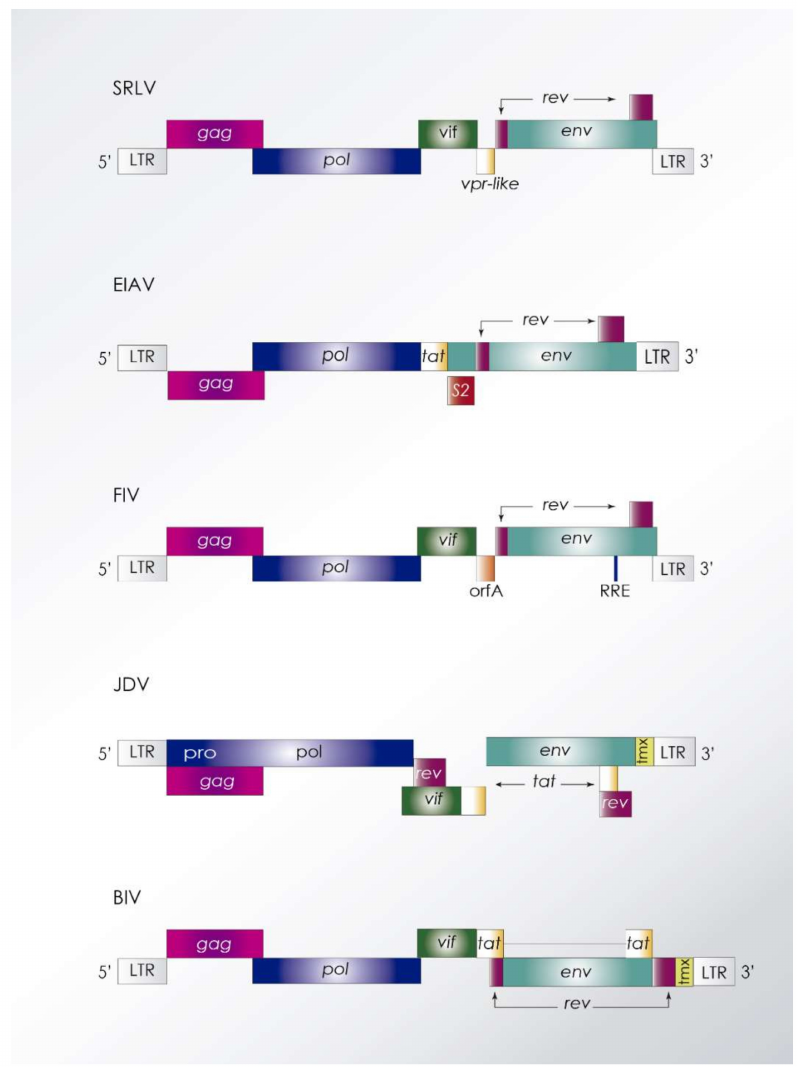
Figure 2. Proviral genomic structure of most common animal lentiviruses. Genes gag , pol , and env , as well as flanking long terminal repeats (LTRs), are common features among animal lentiviruses. Small ruminant lentiviruses (SRLV) encode three accessory genes vif , vpr -like, and rev without evidence of a transactivation activity [8]. Equine infectious anemia virus (EIAV) encodes an S2 gene whose protein may accomplish a function similar to that exerted by HIV Nef [9]. Feline immunodeficiency virus (FIV) encodes orfA with functions similar to Vpr and Nef, since it produces G2 cell cycle arrest and downregulation of E2 ubiquitin conjugating enzymes [10], respectively. Jembrana disease virus (JDV) and bovine immunodeficiency virus (BIV) encode four accessory genes, vif , tat , rev , and tmx that may exert Nef-like properties. Animal lentiviruses also encode a dUTPase subunit involved in regulating cellular dNTP ratio. BIV encodes a dUTPase-related gene without enzymatic